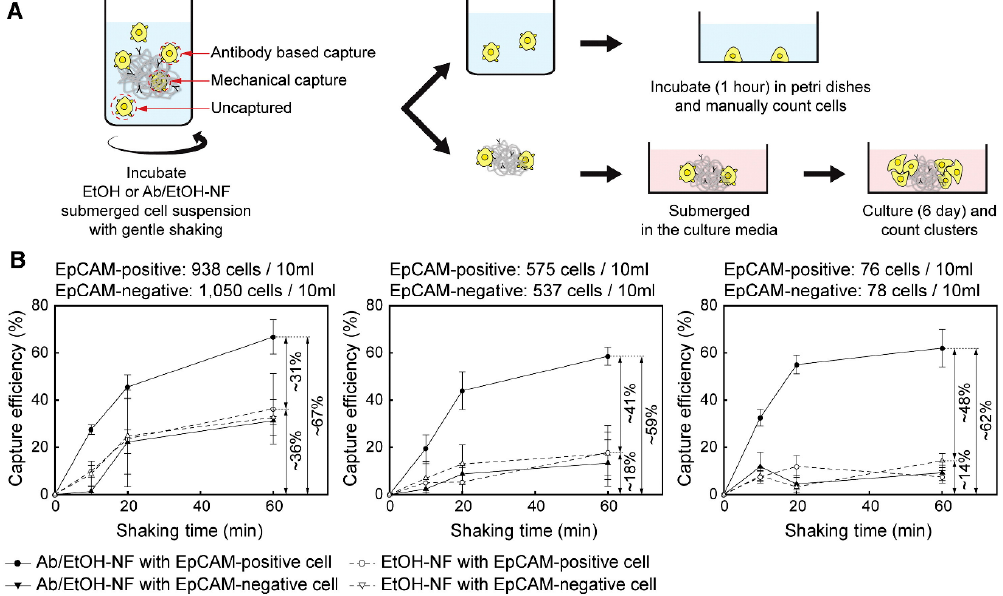
Figure 6. Selective capture capacity of Ab/EtOH-NF. ( A ) Schematic of overall experimental procedure. ( B ) Selective capture capacity of Ab/EtOH-NF with EpCAM-positive cell and EpCAM-negative cell ( B ) Selective capture capacity of Ab / EtOH-NF with EpCAM-positive cell and EpCAM-negative with ~1000, ~500 and ~100 cells per 10 mL ( n = 3) [58]. cell with ~1000, ~500 and ~100 cells per 10 mL ( n = 3). Reproduced with permission from